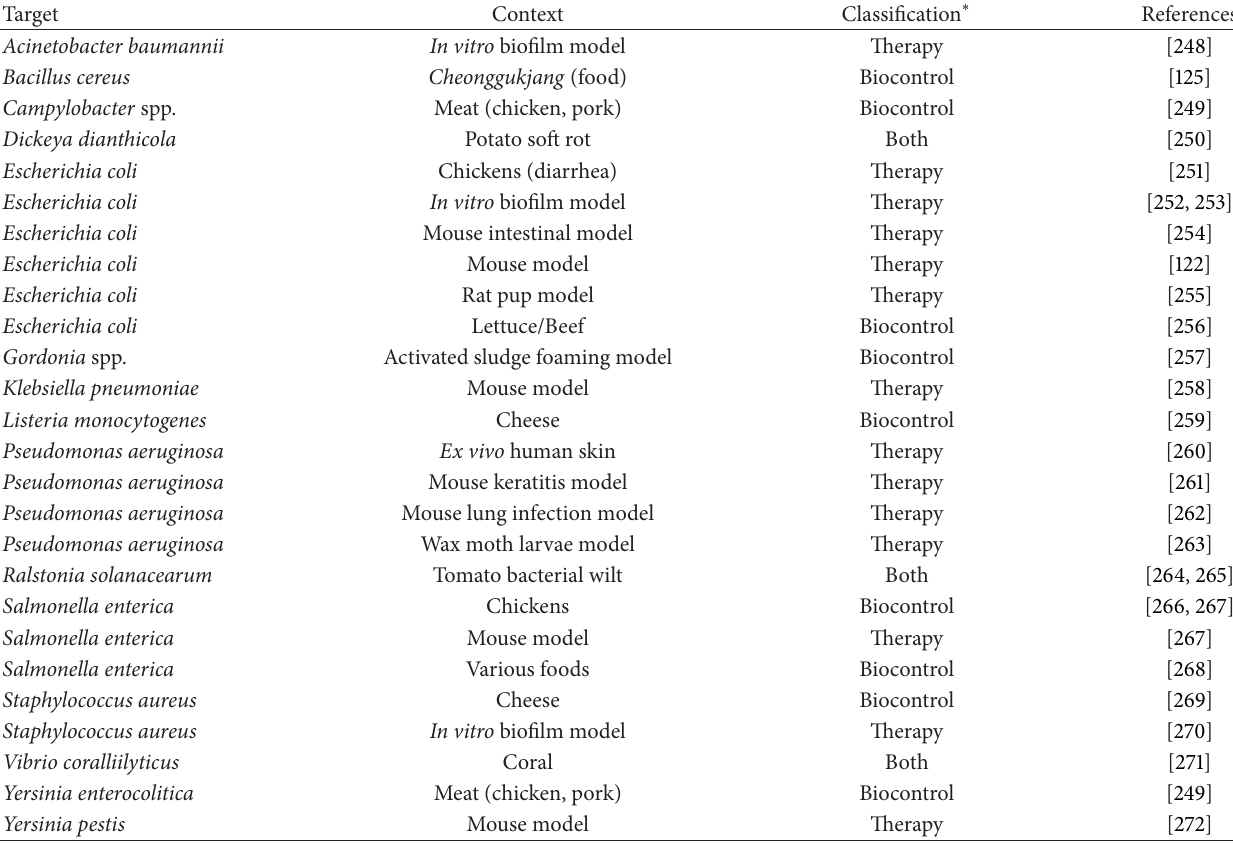
Table 2: Studies involving phage-mediated biocontrol and therapy of bacteria from